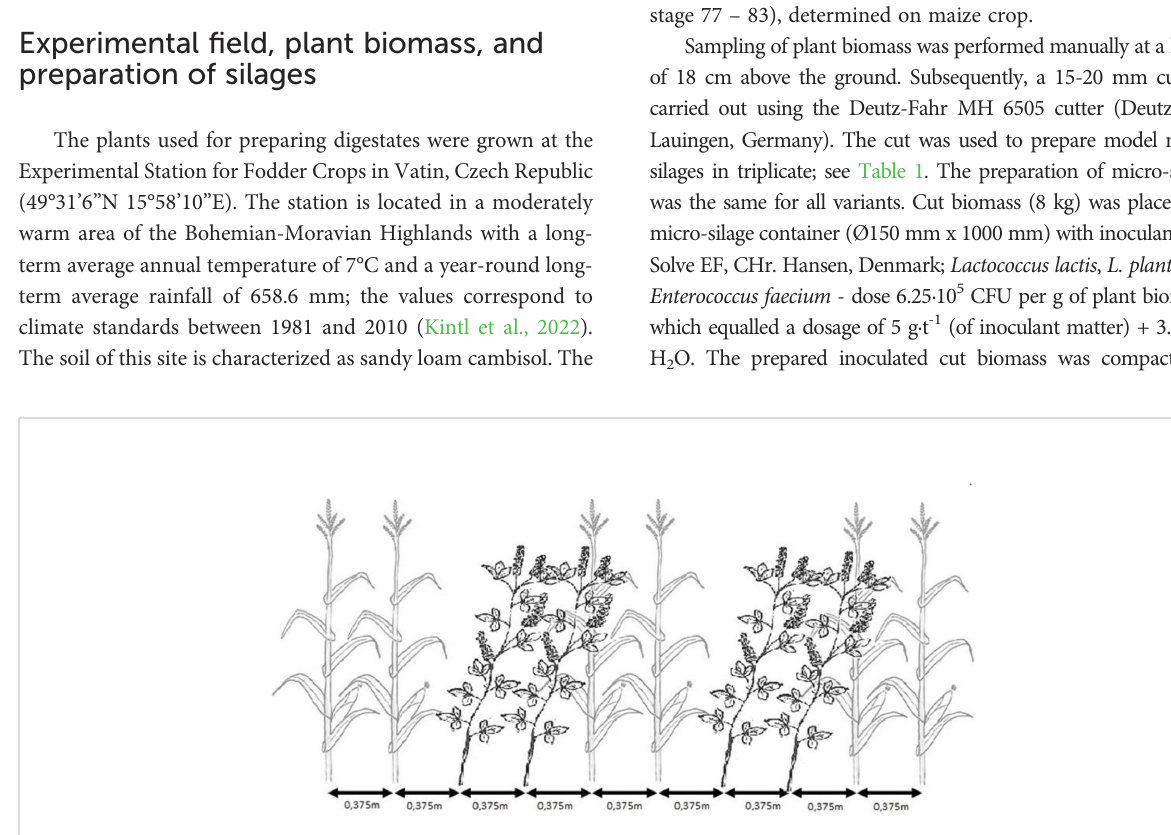
FIGURE 1 Scheme of sowing mixed culture of maize and selected legumes (Kintl et al.,